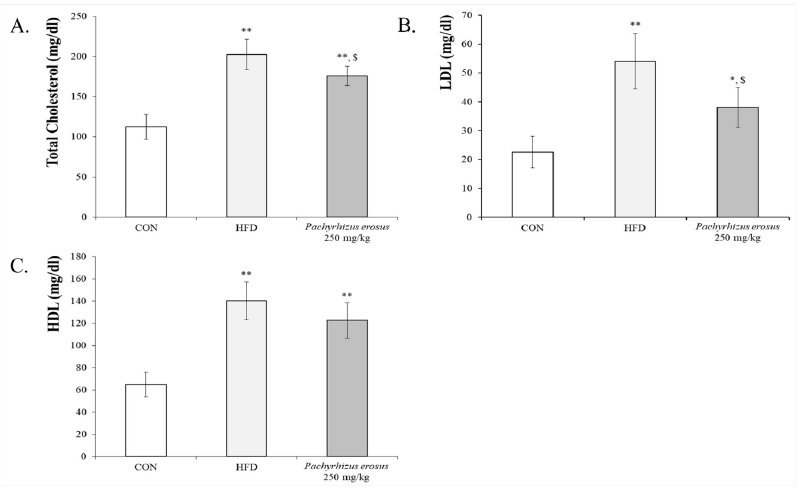
Figure 2. P. erosus controlled the HFD-induced changes as obesity biomarkers in the serum. ( A ) P. erosus total cholesterol was increased by HFD feeding, but P. erosus suppressed the upregulation of total cholesterol due to HFD. ( B ) P. erosus down-regulated the LDL levels in the serum, and HFD increased the level of that. ( C ) P. erosus treatment slightly decreased the level of HDL, but there was no statistical comparison. Table in Figure 2. The change of obesity-related parameters in the serum. The results are described as a mean ± standard deviation. N = 12. * p < 0.05 vs. control; ** p < 0.001 vs. control; $ p < 0.05 vs. HFD-induced obesity.